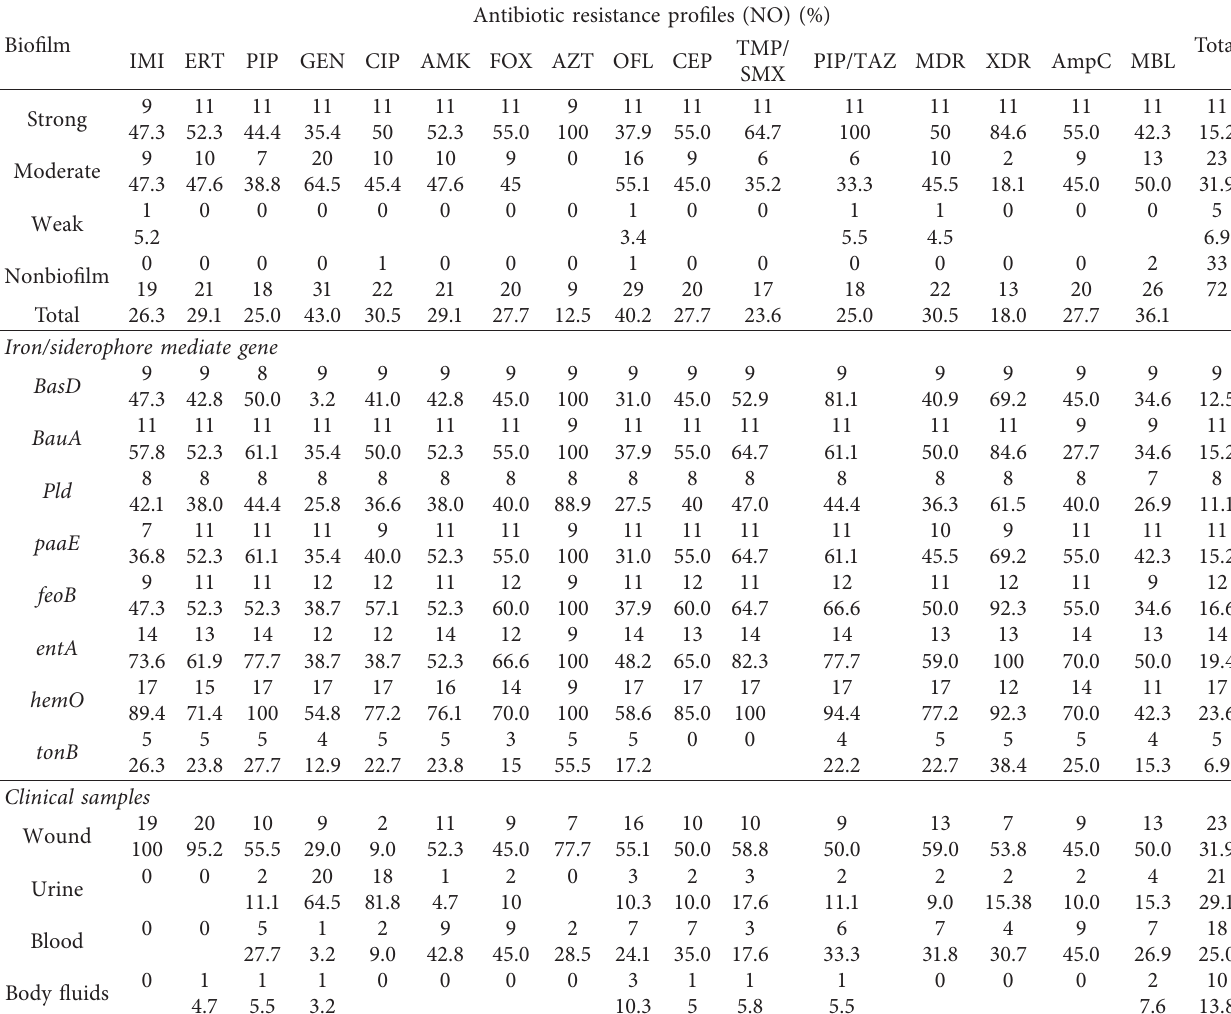
Table 2: The biofilm-forming capacity of A. baumannii and percentages of their iron/siderophore mediate gene.